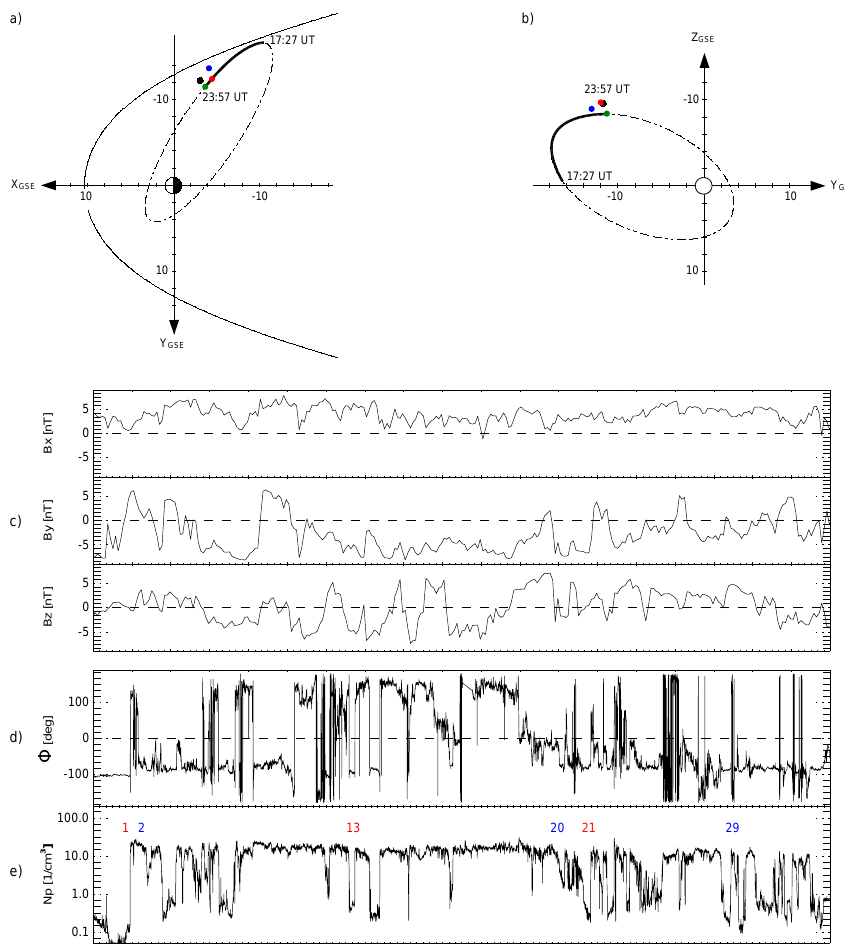
Fig. 1. Overview of spacecraft position and key parameters. Top: GSE XY ( a ) and YZ ( b ) projections of spacecraft orbit. The spacecraft separation distances are magnified by a factor of ∼ 5 to show the tetrahedron configuration. The thick black lines show the trajectory during the time interval discussed in this paper. Panels ( c ) : the three components of the IMF measured at ACE, shifted to account for the propagation delay. Panel ( d ) : magnetic field orientation observed at Cluster C1. The angle φ is the azimuth angle in the (L,M)-plane of the boundary- normal coordinate system; φ =0 ◦ is along the L-axis, which is pointing essentially northward. φ =90 ◦ is along the M axis, which is pointing tailward along the magnetopause. Panel ( e ) : plasma density from the CIS HIA instrument on C1. The labelled crossings (blue for inbound, red for outbound) are discussed in Sect.